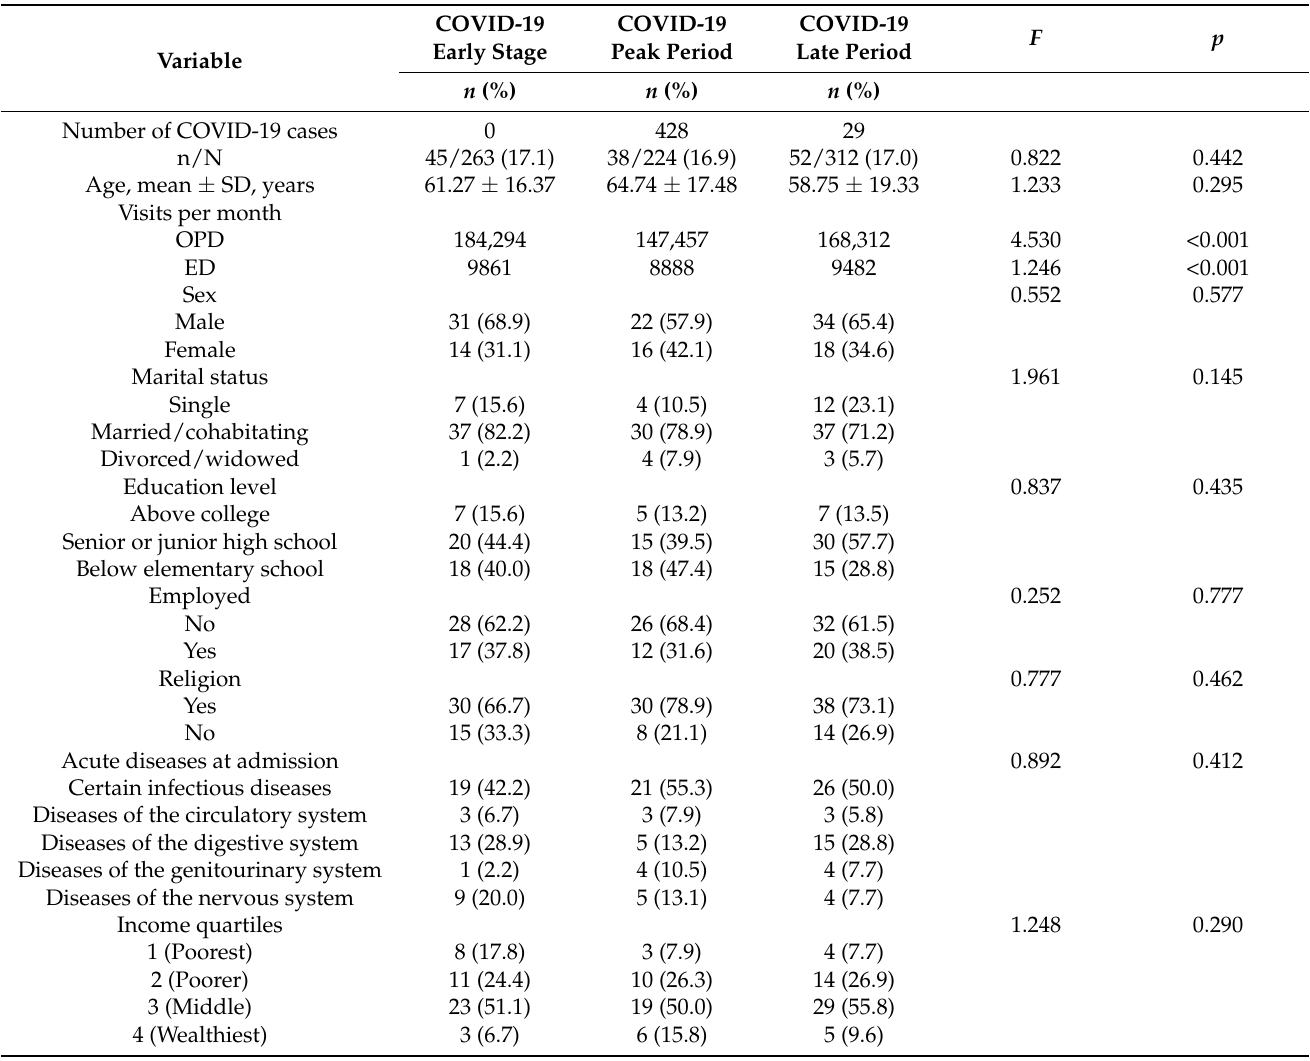
Table 1. Participant characteristics of the different periods of the COVID-19 outbreak in Taiwan.